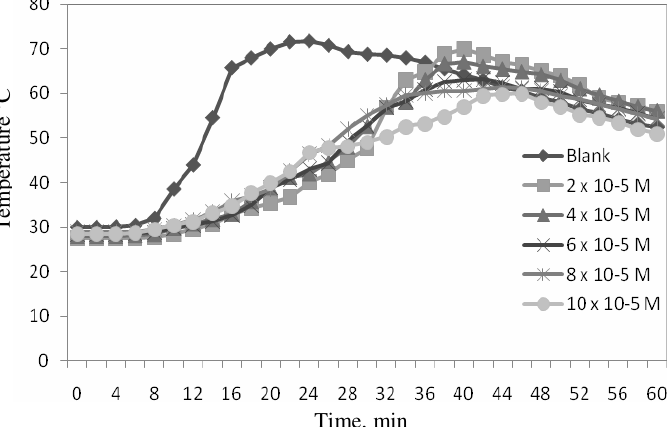
Figure 3. Variation of temperature with time for the dissolution of aluminium in the absence and in different concentrations of nizoral. Table 1. Calculated values of Reaction Number (RN) and Inhibition efficiency (% I) in the absence and presence of different concentrations of nizoral System/Concentration,